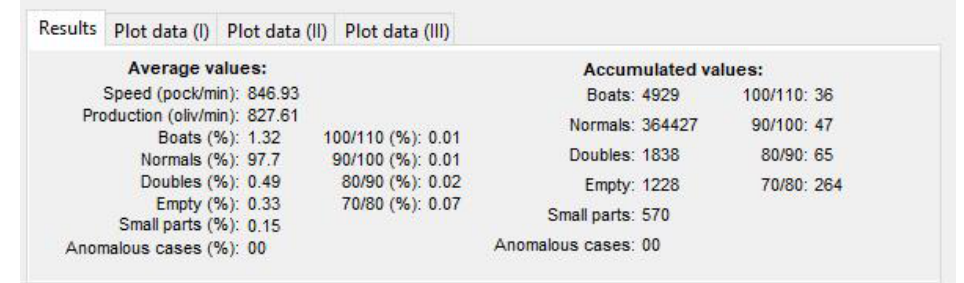
Figure 16. Settings dialogue box of the GUI from Matlab.